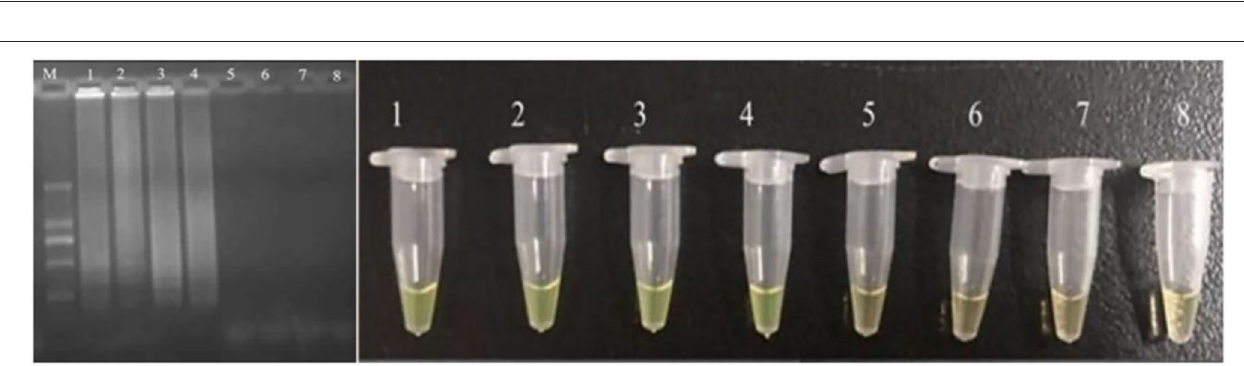
FIGURE 2 | Sensitivity of the CPA assay in genomic DNA of P. acidilactici with pheS genes by 1.5% agarose gel electrophoresis and mixed chromogenic agent; M-DNA marker; 1–6 refer to 52, 5.2 ng/ µ l, 520, 52, 5.2 pg/ µ l, and 520 fg/ µ l; 7 refers to negative control.